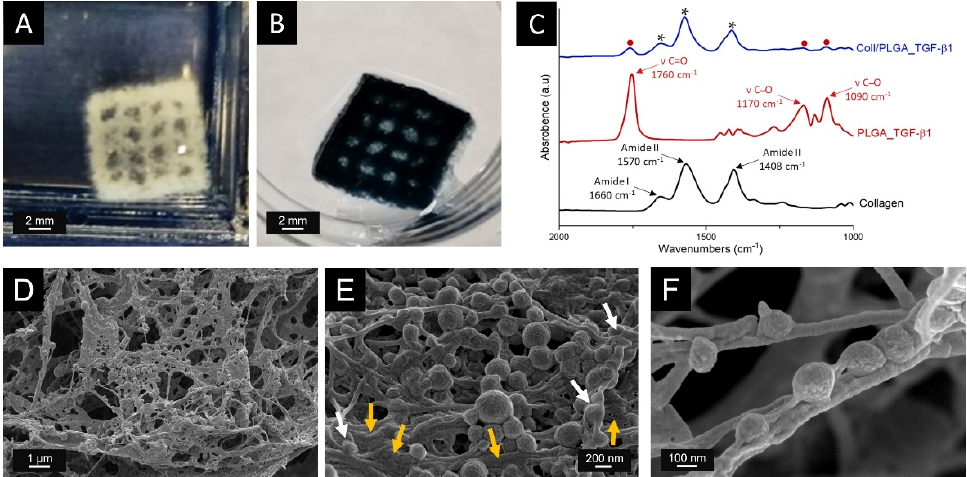
Figure 6. Coll/PLGA_TGF- β 1 scaffolds characterisation: Optical images ( A , B ), ATR-FTIR spectra ( C ) and FESEM images ( C – F ) of 3D printed Coll/PLGA_TGF- β 1 scaffolds. 3D mesh-like structure obtained by the optimised extrusion printing of Coll/PLGA TGF- β 1 suspension before ( A ) and after ( B ) the genipin crosslinking treatment. ( C ) ATR-FTIR spectra of the different materials: collagen (black line), PLGA_ TGF- β 1 nanoparticles (red line), Coll/PLGA_TGF- β 1 (blue line, * collagen and • PLGA_ TGF- β 1 peaks). FESEM images of Coll/PLGA_TGF- β 1 scaffold at different magnification: 25,000× ( D ), 100,000× ( E ) and 250,000× ( F ). ( E ) Orange arrows indicate collagen fibrils properly reconstructed after incubation at 37 °C and white arrows highlight the successful embedding of PLGA_TGF- β 1 nanoparticles into the collagen matrix.